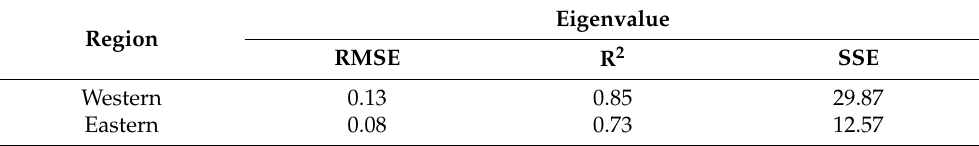
Table 3. Fitting eigenvalues for different regional equations. Region